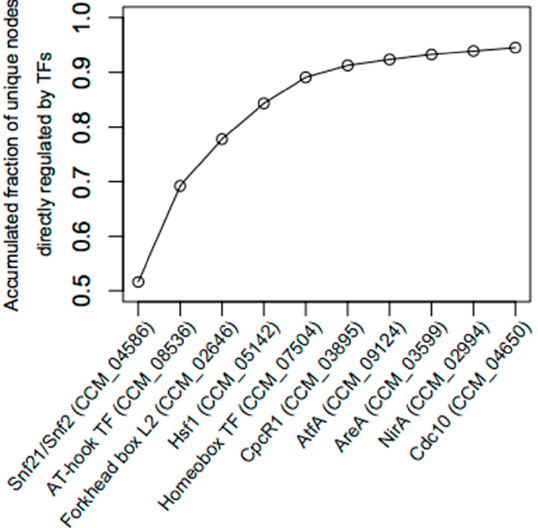
Figure 3. The accumulated fraction of unique genes directly regulated by TFs. The fraction rises to ~0.9 when the first five TFs are included. Here, they are assigned as key TFs.